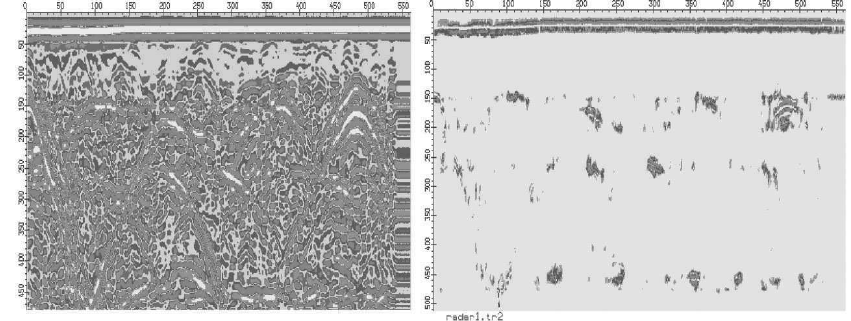
Figure 8. Subsurface radar sounding profile: before (left) and after (right) processing. Three rows of low-sized targets.